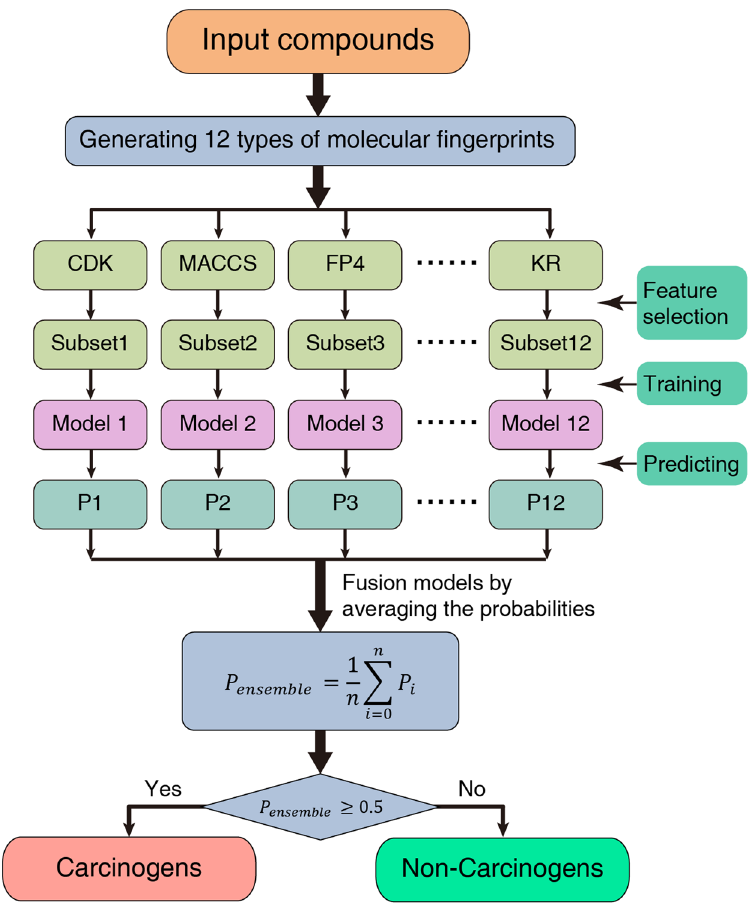
Figure 5. Flowchart to show the ensemble model building